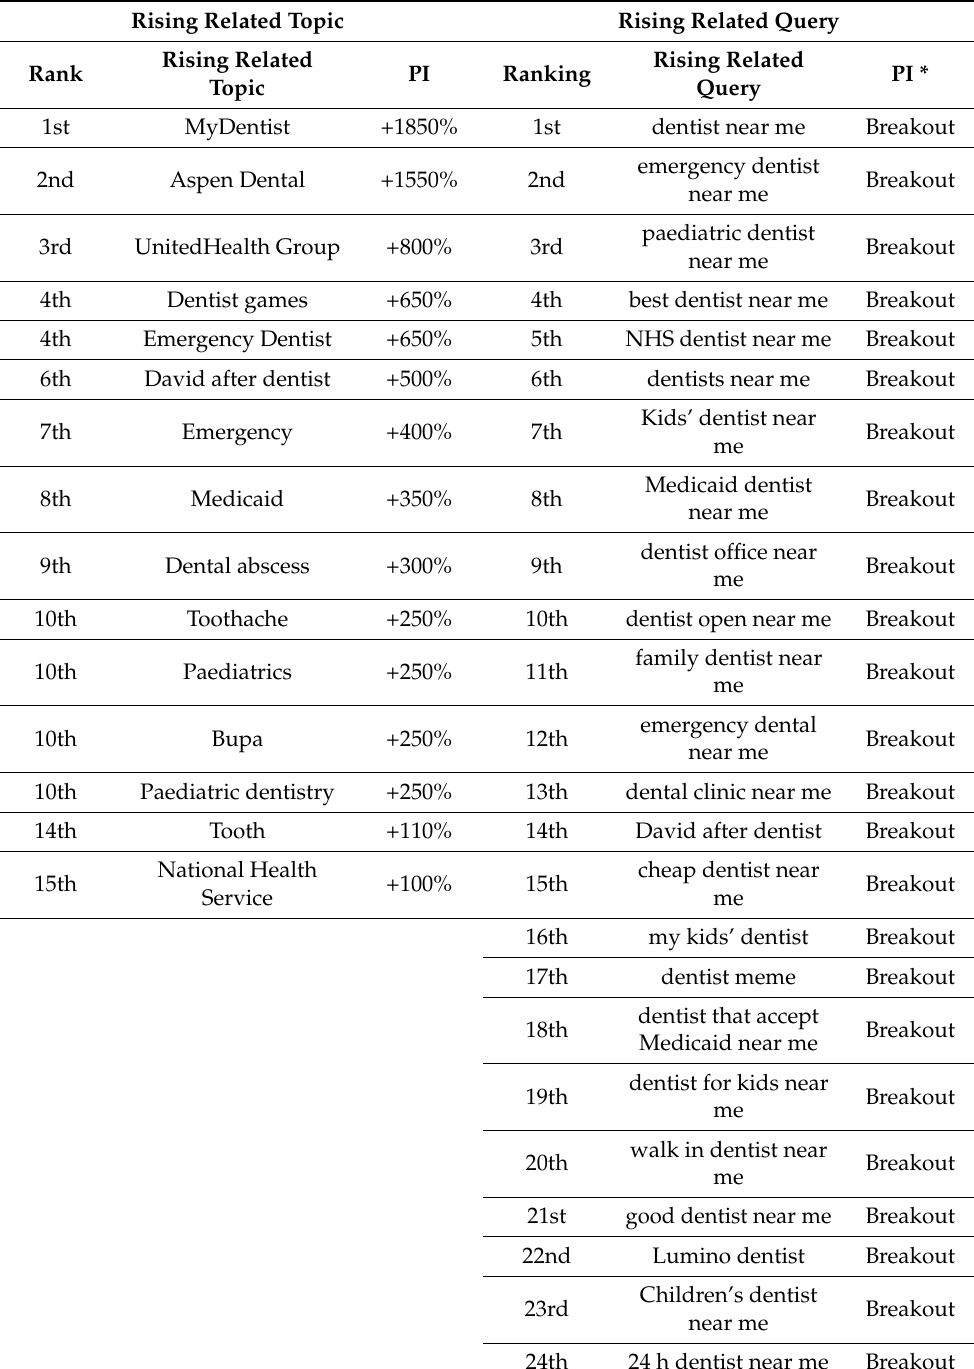
Table 3. The list of rising related topics and queries on